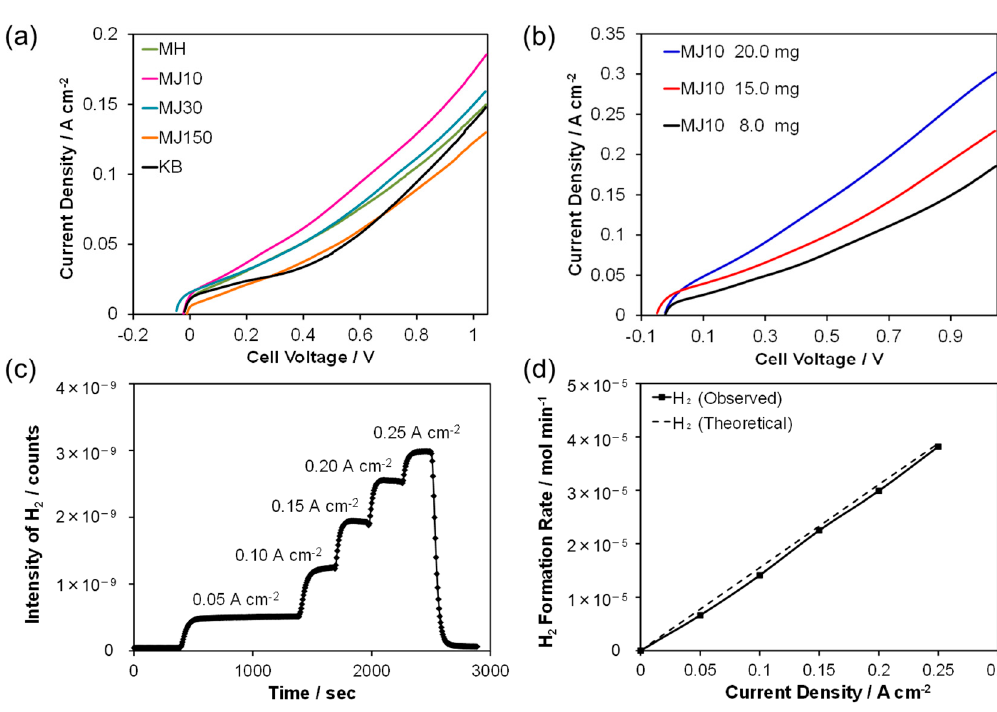
Figure 3. Characteristics for cellulose electrolysis of cells using carbon cathodes at 150 °C: I–V curves of ( a ) cells using KB, MH, MJ10, MJ30, and MJ150 cathodes and of ( b ) the cell using the MJ10 cathode. ( c ) Mass spectrometer (MS) spectra for hydrogen and ( d ) hydrogen formation rates at the MJ10 cathode. Theoretical values are shown by the dotted lines.